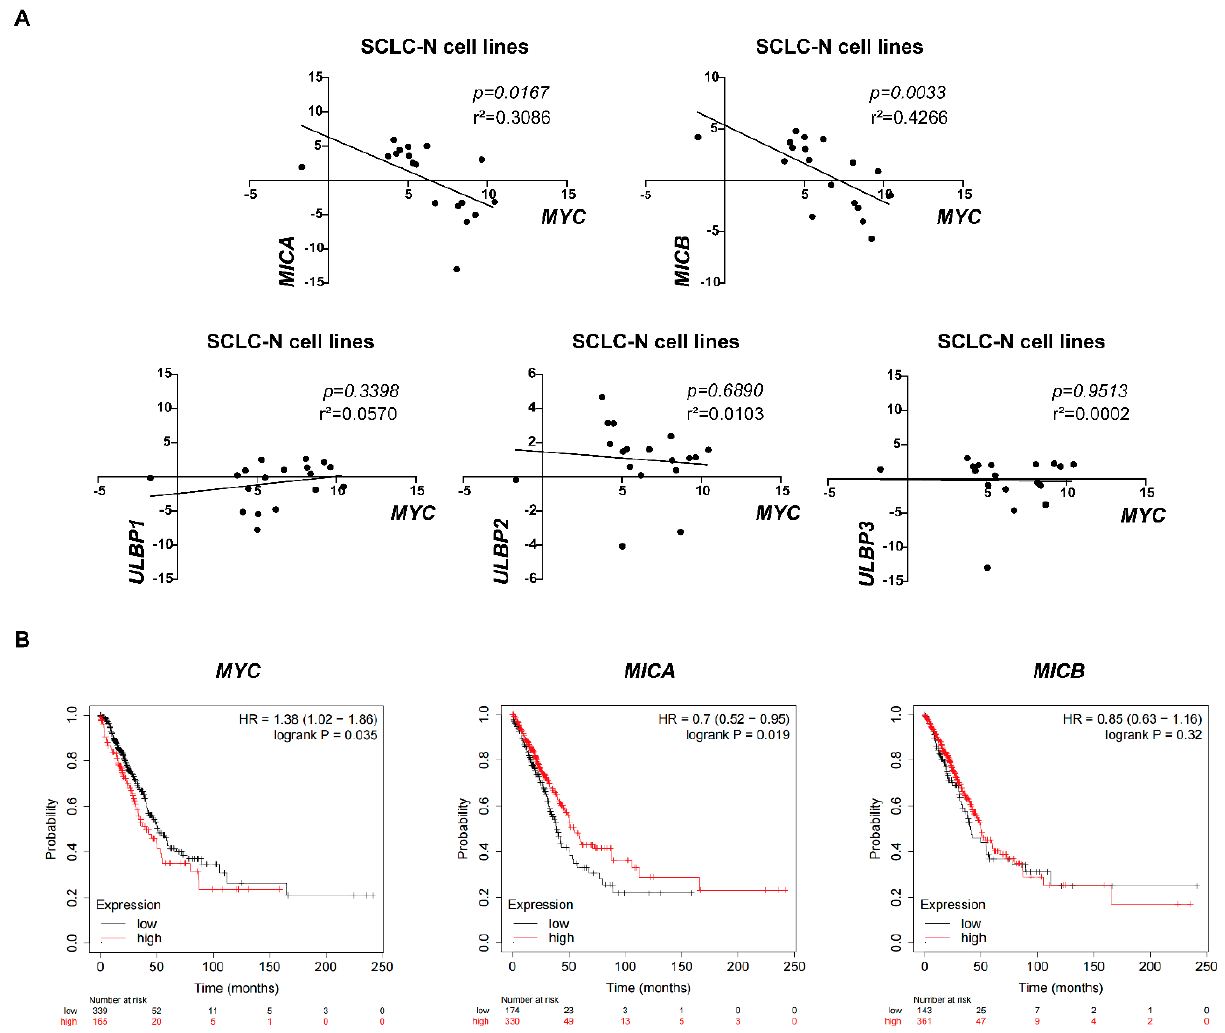
Figure 5. The negative correlation between MYC and NKG2DL expression in SCLC-N cells and lung cancer patients. ( A ) CCLE data analysis of the correlation between MYC and MICA , MICB , ULBP1 , ULBP2 , or ULBP3 in SCLC-N cells lines, respectively ( n = 18). ( B ) Kaplan-Meier survival curve of MYC , MICA , and MICB expression groups, respectively ( n = 504).